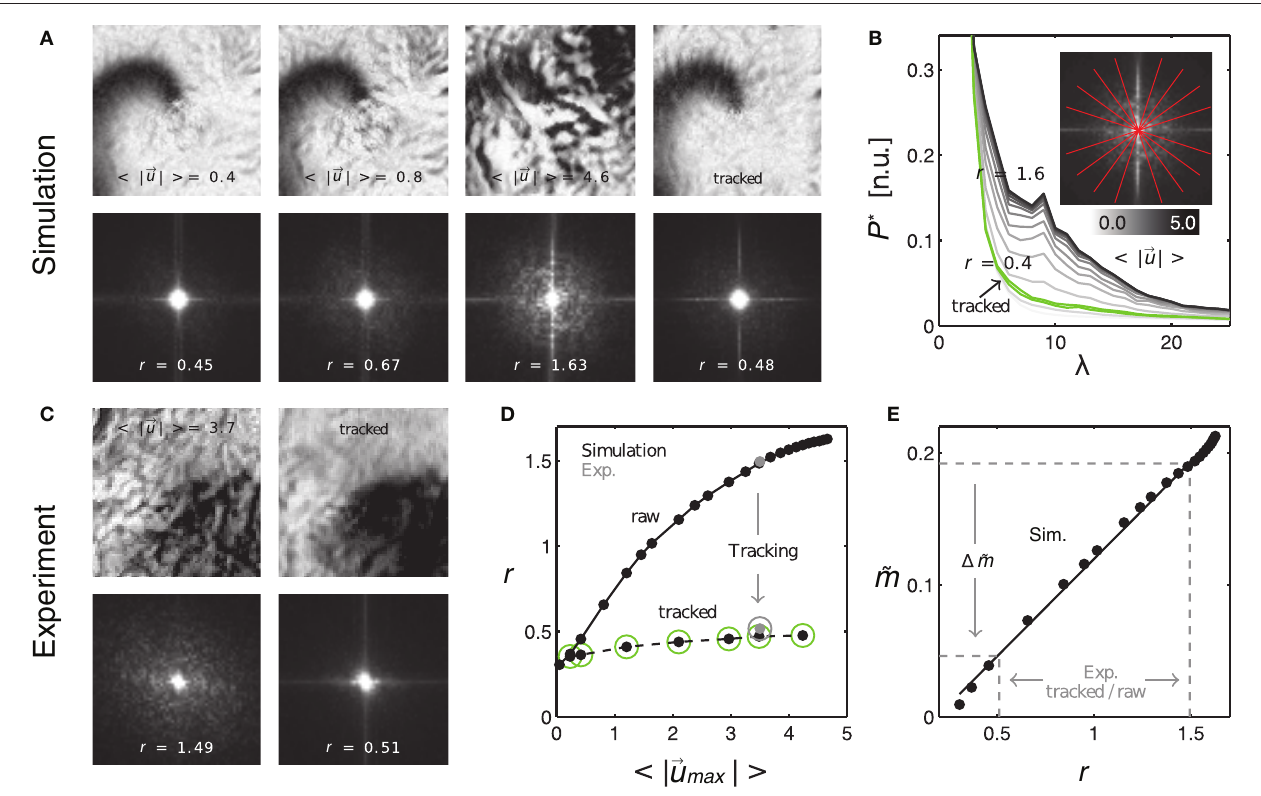
FIGURE 10 | Evaluating tracking performance and residual motion artifacts by comparing synthetic to experimental data. (A) Synthetic optical maps before (panels 1–3) and after (panel 4) tracking. Increasing amplitudes of motion (panels 1–3: 0.4, 0.8, and 4.6 pixel) cause an increase in motion artifacts. Tracking and motion stabilization (panel 4) inhibits (residual) motion artifacts to levels found at 0.4–0.8 pixels of motion before tracking. Spectral maps obtained from the optical maps (bottom) show an increase in high-frequency spectral components with increasing motion. Tracking and motion compensation decreases the high-frequency spectral components to a level comparable to the left image ( r = 0.45) with low amounts of motion (0.4 pixels). (B) Radial profiles of normalized spectral maps indicating an increase in width of the profiles (color-coded from gray to black, r = 0.4 to 1.6) with increasing motion and decrease in width after tracking (green curve). (C) Comparison with experimental data. Tracking and motion-stabilization reduces motion artifacts and radial profile width r (pre-tracking r = 1.49, post-tracking r = 0.51). (D) Profile width r over magnitude of motion < |E u | > for raw and tracked (circles) simulated (black dots) and experimental data (gray dots). (E) Linear increase of motion artifact strength ˜ m with spectral profile width r . Motion artifact reduction 1 ˜ m calculated for experimental data via the linear relationship between motion artifact strength (obtained in simulations mimicking experimental data) and spatial high-frequency components in optical maps (quantifiable by r with both experimental and simulation